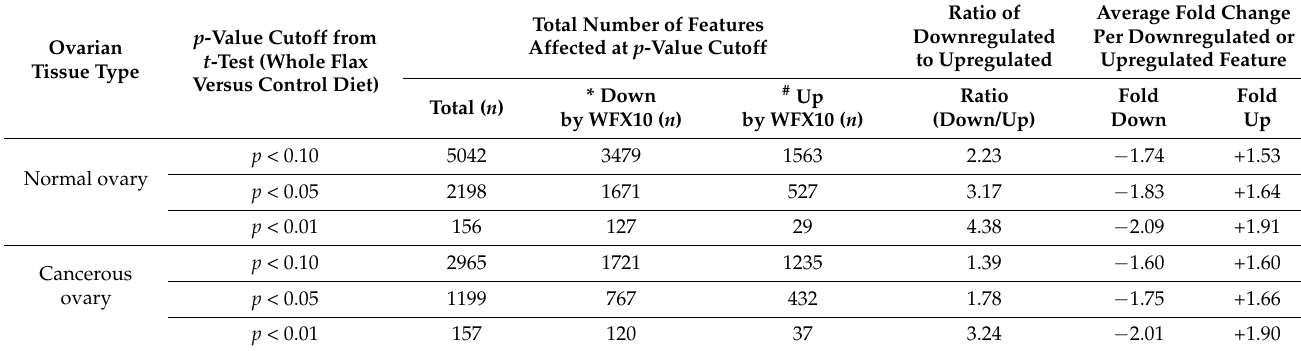
Table 1. Microarray feature expression in laying hen ovaries (WFX10 versus CTL).